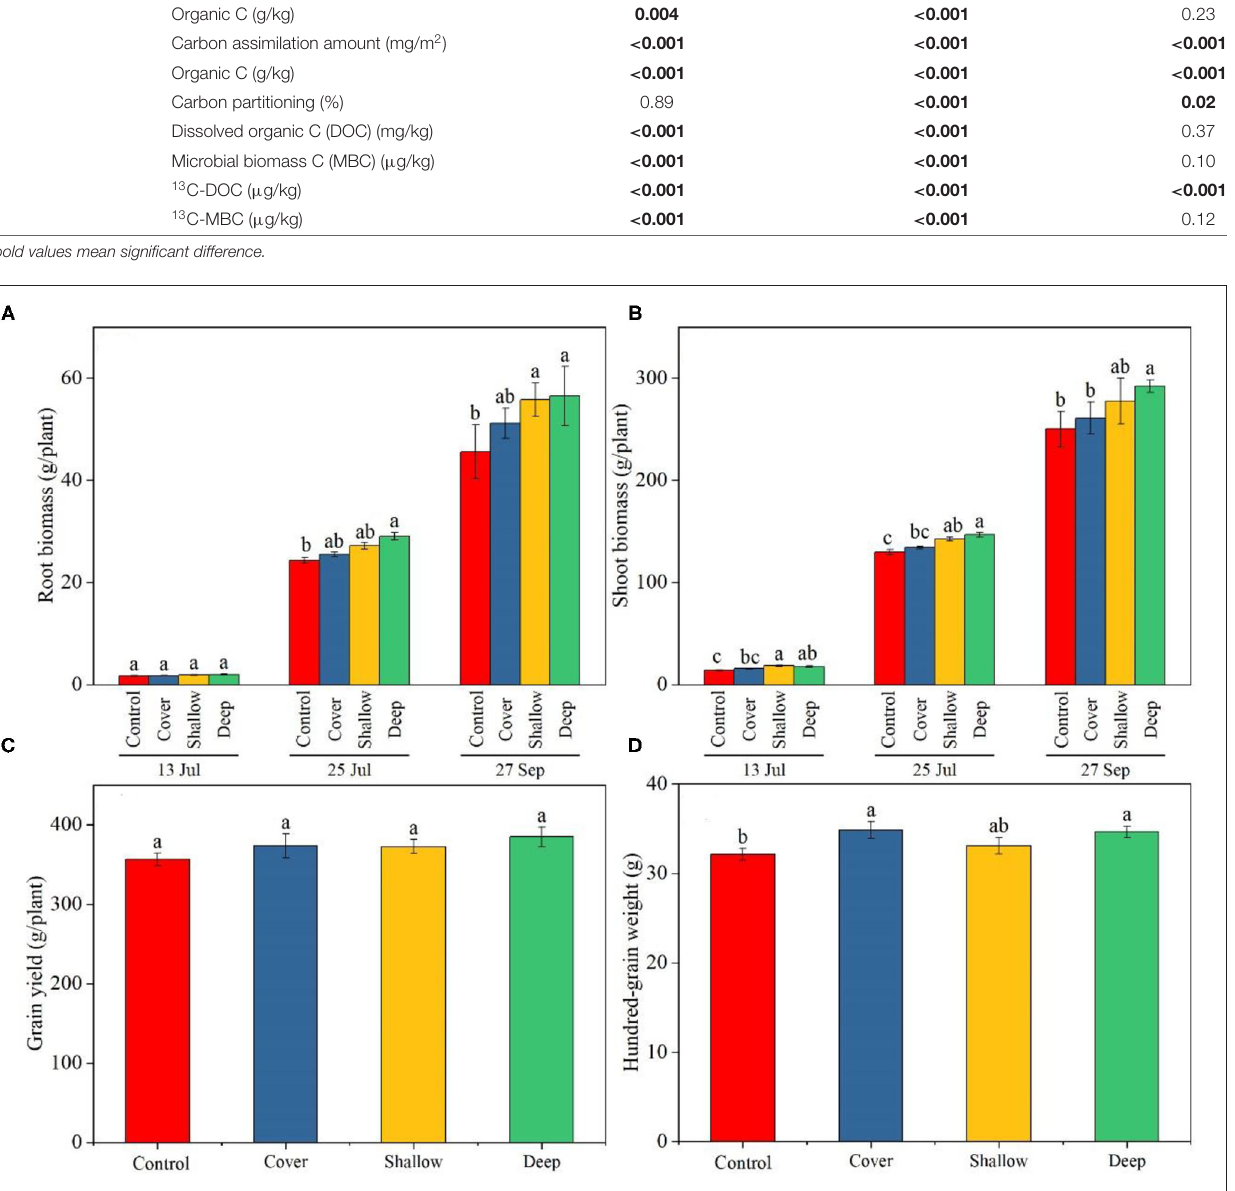
compared with the control on all three sampling dates ( Figure 3A ), but the straw cover treatment significantly